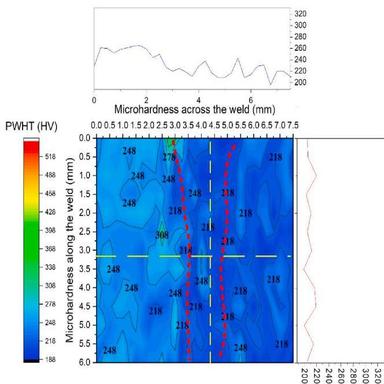
2D contour profile plot of microhardness across the specimen in PWHT state.